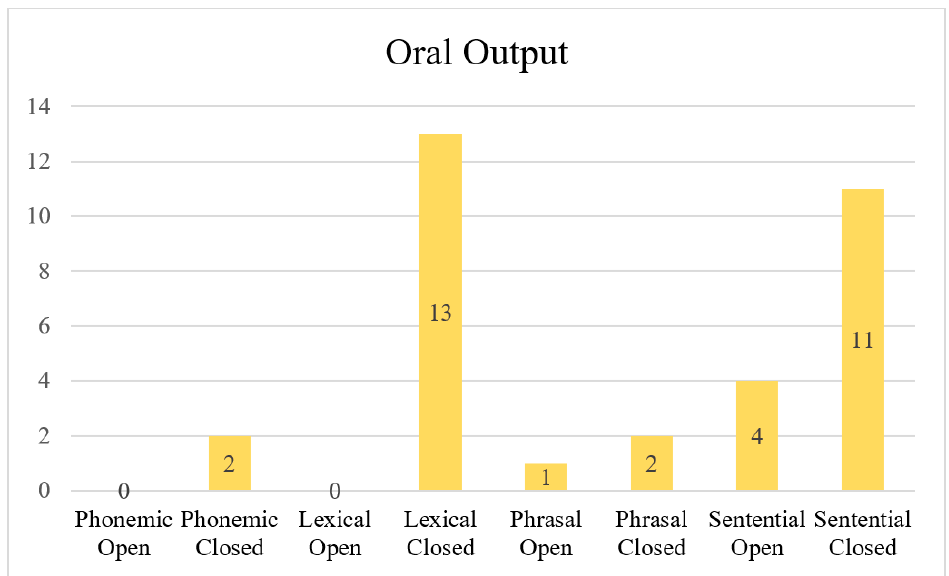
Figure 5. Type of oral output produced by learners.